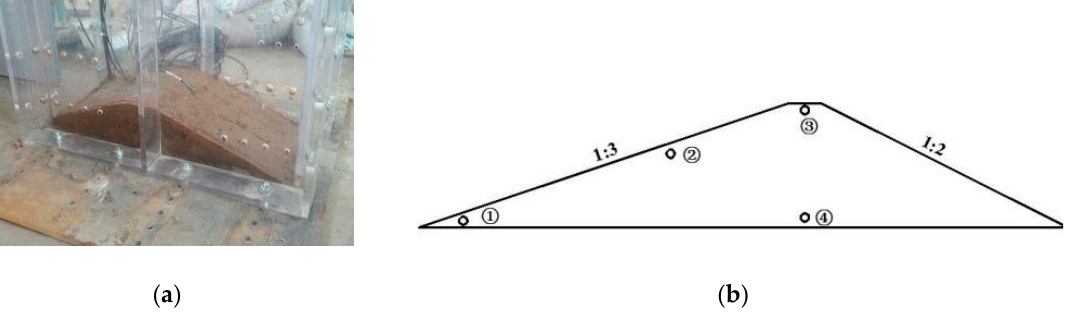
Figure 7. Test sample geometry. ( a ) Picture of sample; ( b ) Locations of suction pressure monitoring sensors.